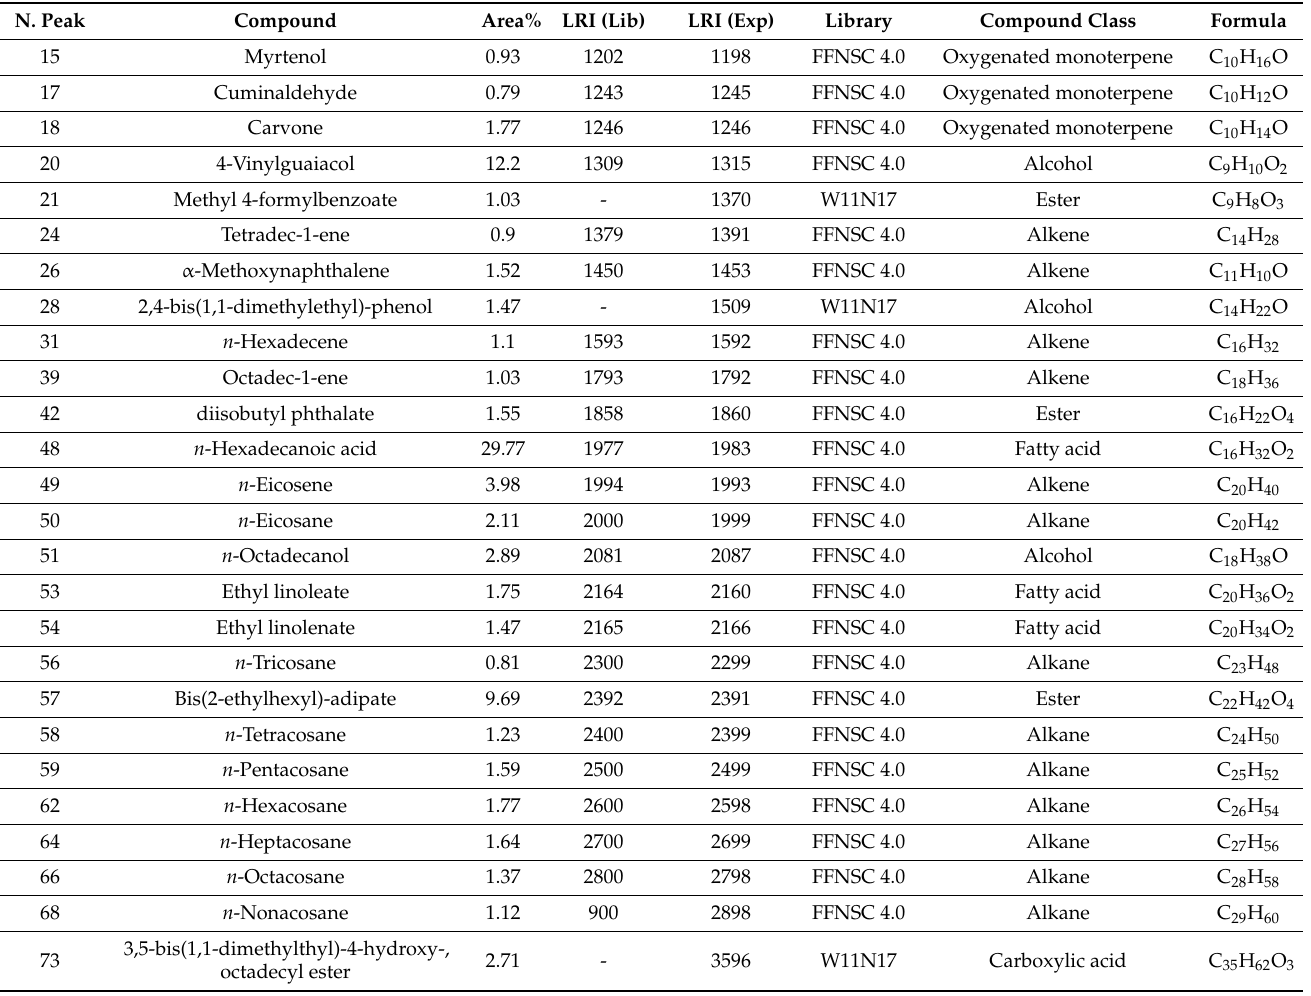
Table 1. List of major volatile compounds detected in the hexane fraction (VF1) of C. althaeoides L. roots by